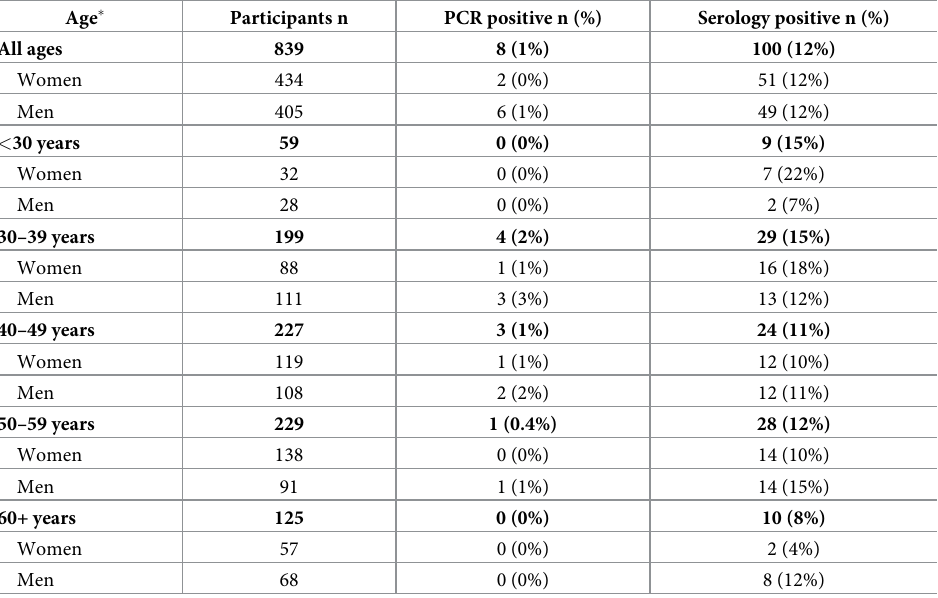
Table 2. Distribution of SARS-CoV-2 testing results by age and